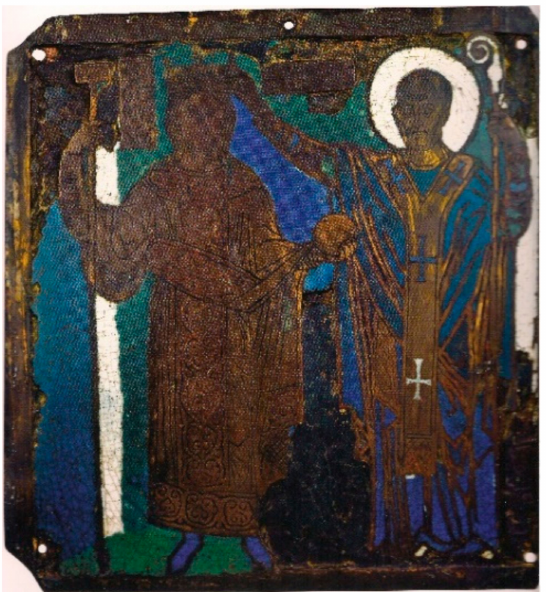
Figure 4. St. Nicholas Blessing Roger II , enamelled plate, 1140–1149. Bari, Museum of the Basilica di San Nicola. Photo took by author.